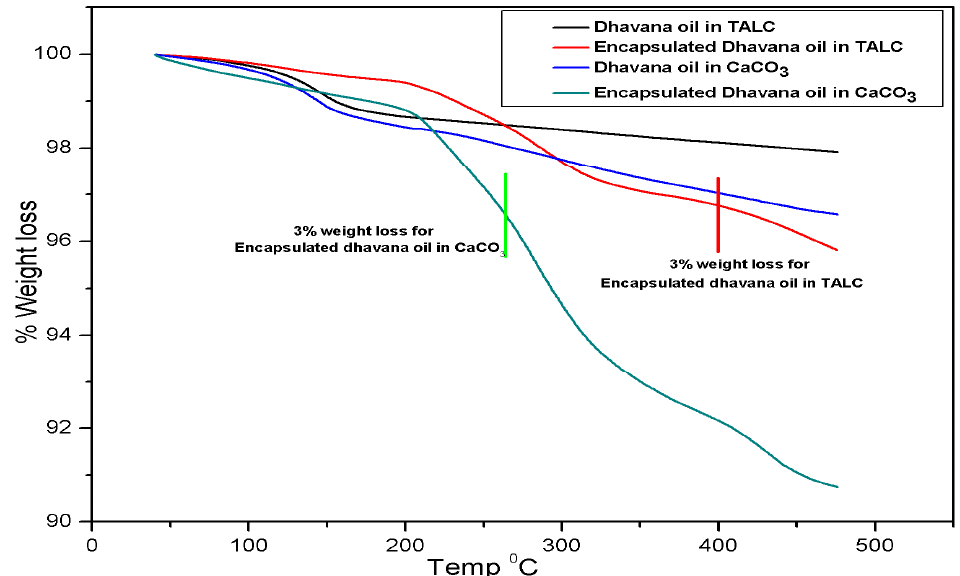
Figure 3. TGA analysis of the neat and encapsulated Dhavana oil in TALC and CaCO